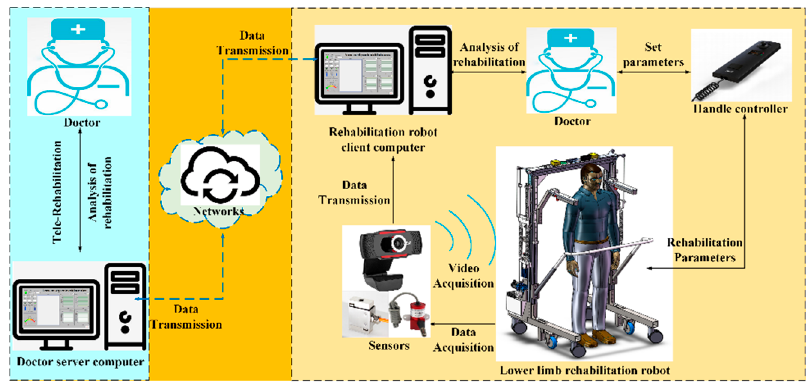
Figure 4. The framework of telerehabilitation robot interaction system.